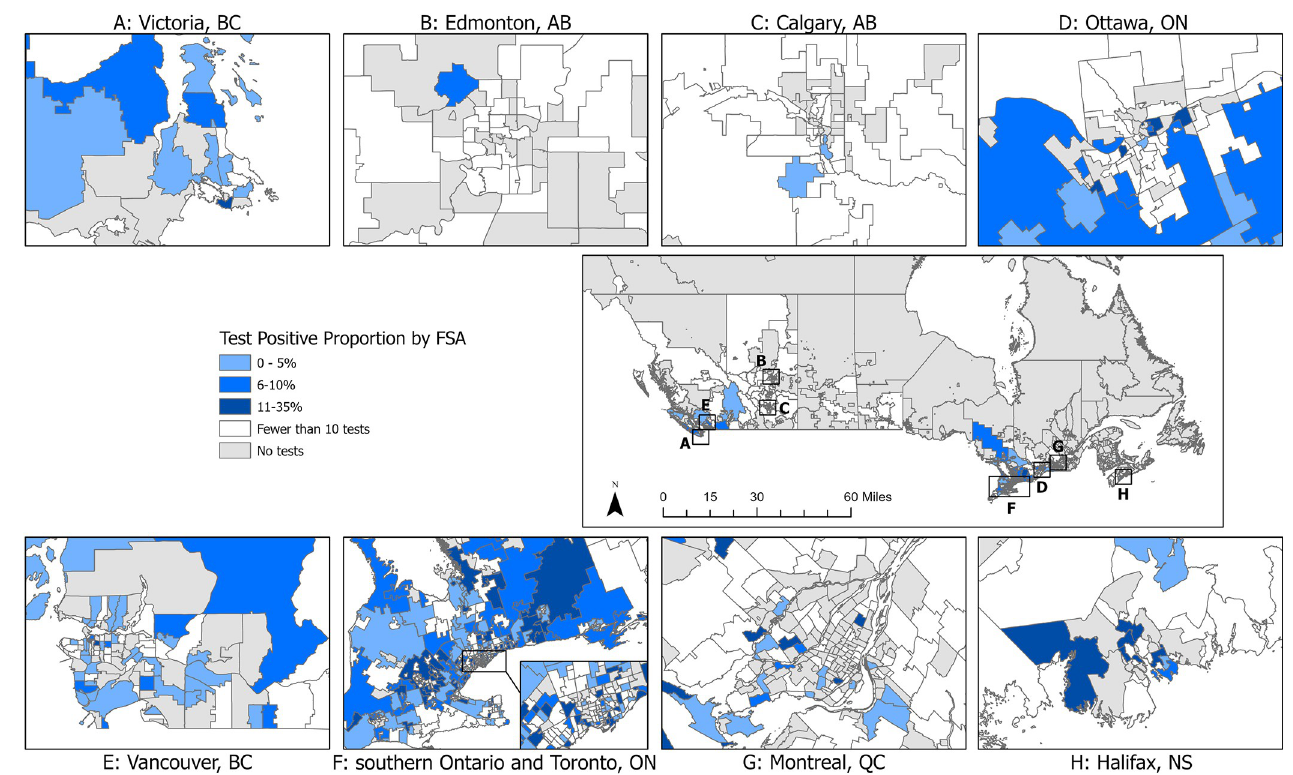
Fig 5. Test-positive proportion of canine Leptospira PCR tests by forward sorting area (FSA) in Canada, 2009–2018. FSA for submitting veterinary location.